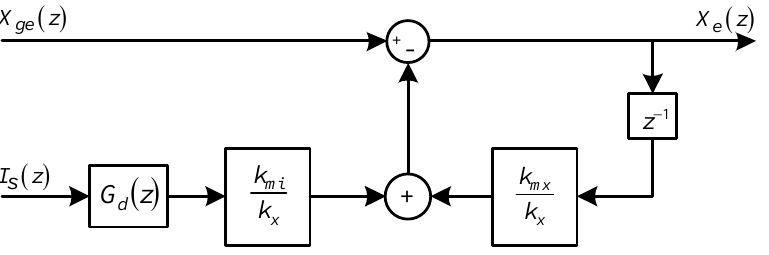
Figure 5. Linearized block diagram ( z -domain) of self-sensing